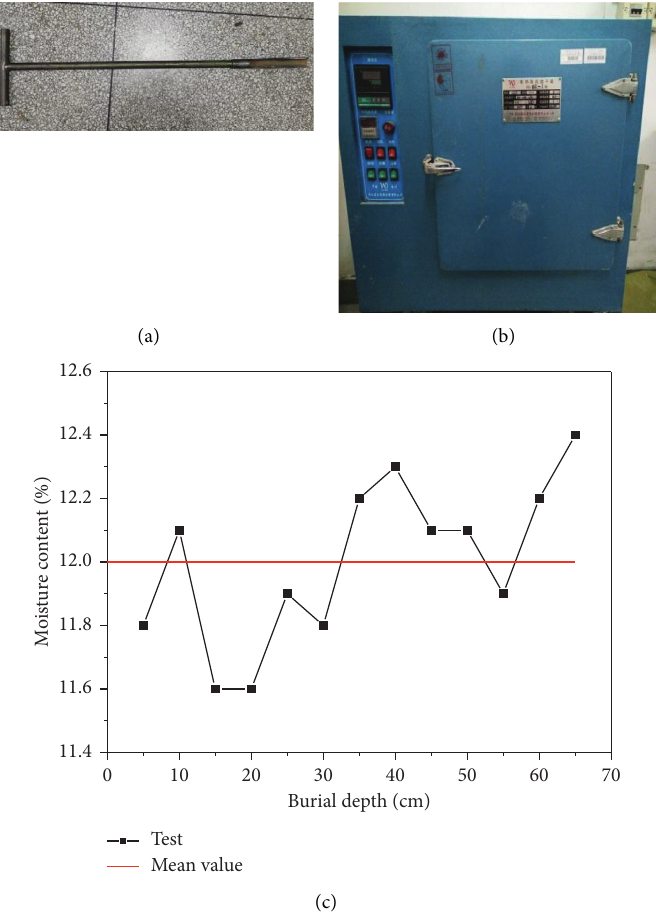
Figure 2: Moisture content test of the coal sample. (a) Luoyang shovel. (b) Oven. (c) Moisture content.